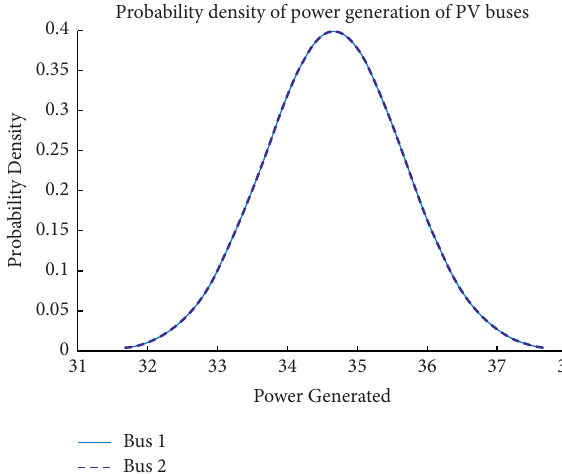
Figure 12: Power density distribution at buses 1 and 2.